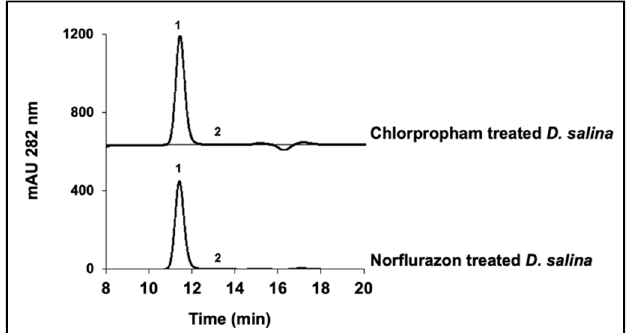
Figure 5. HPLC chromatograms of phytoene extracts from D. salina cultures treated with 20 µM of chlorpropham or 5 µM of norflurazon, only showing the region of interest in the chromatogram.